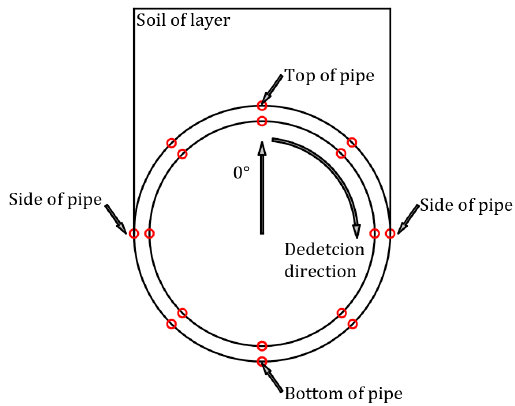
Figure 10. Circumferential detection and position of pipes.